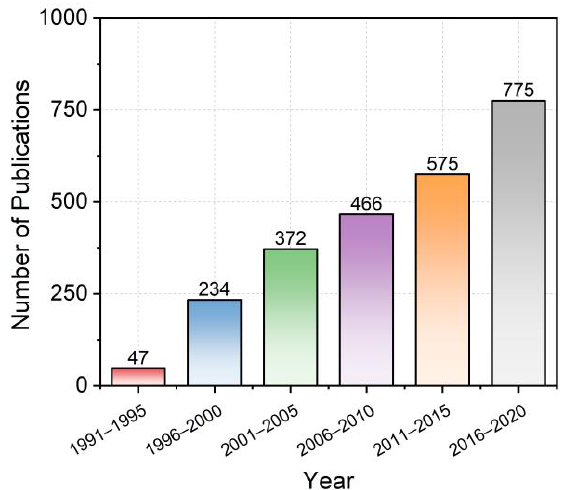
Figure 8. The number of publications on MR sensors from 1991 to 2020. The data were obtained from the Web of Science core collection with the keyword “magnetoresistance sensor”.